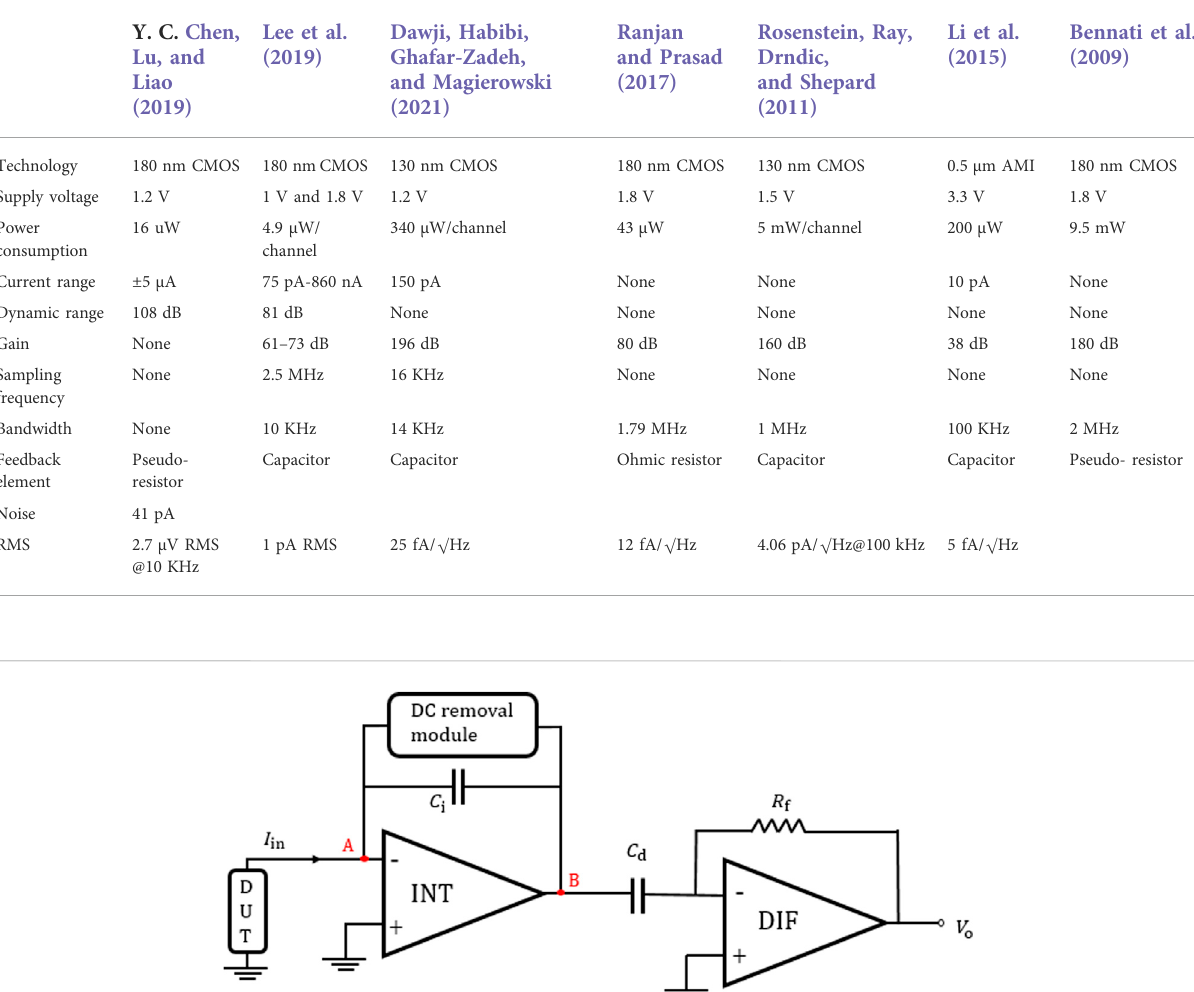
TABLE 2 Performances, comparison, and summary of previous works using the DT approach.